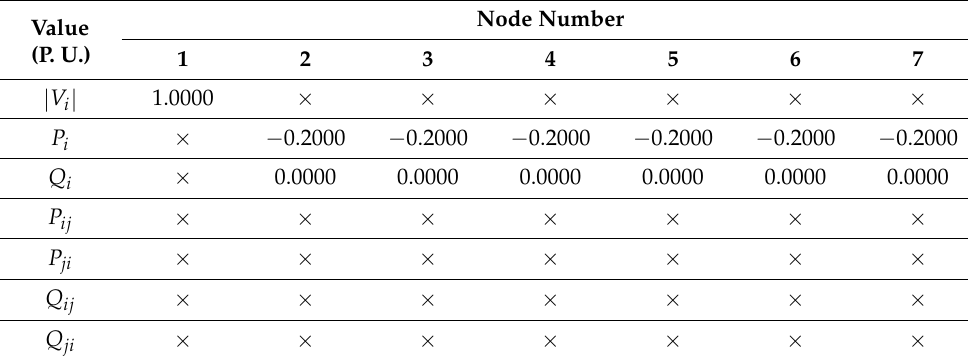
Table 1. Estimated input